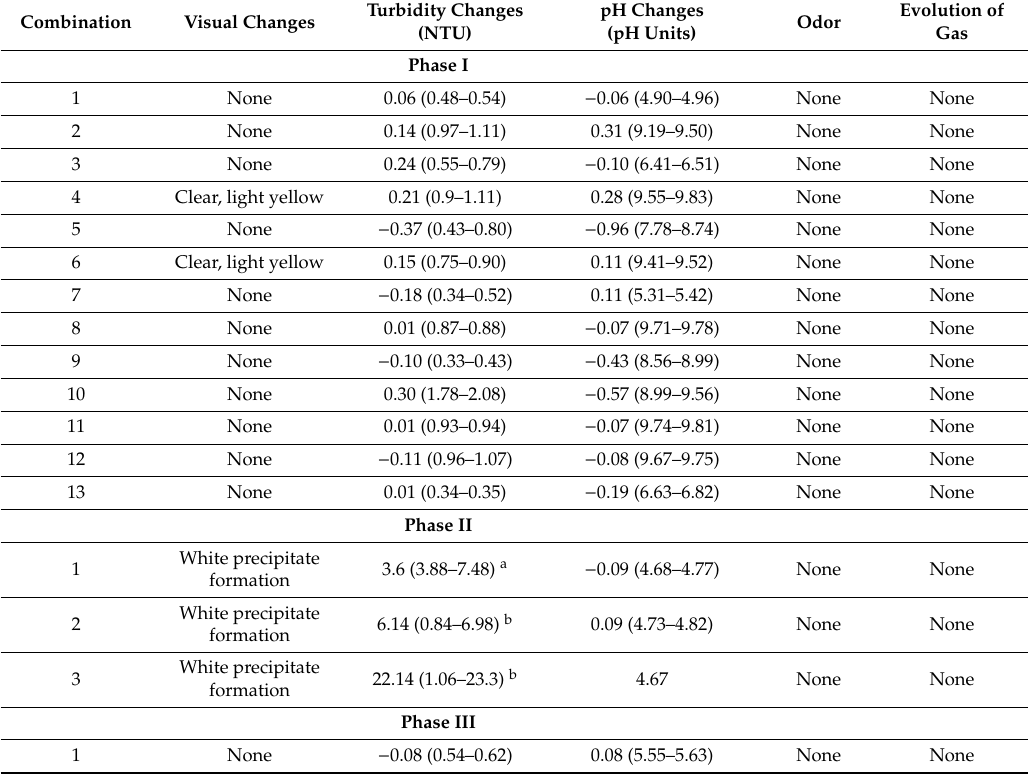
Table 6. Results of the physical compatibility of various solutions at 240